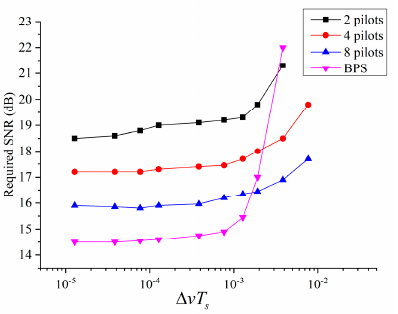
Figure 4. The comparison for phase noise estimation with PA and BPS for the 128-sub-carrier CO-OFDM SDM system. The required SNR is tested at BER of 3.8 × 10 − 3 (7% HD-FEC threshold).